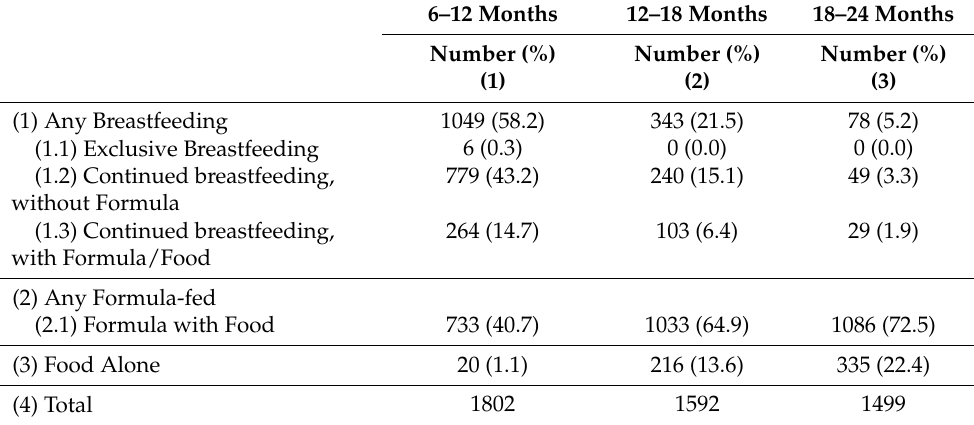
Table 2. Feeding behaviors among sample children aged 6–24 months in rural China ( n =